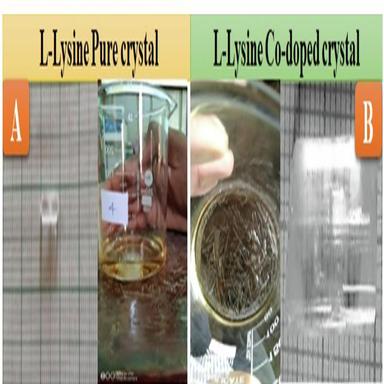
Illustration as grown single crystals of pure (A) and (B) co-doped L-LGBCAC.